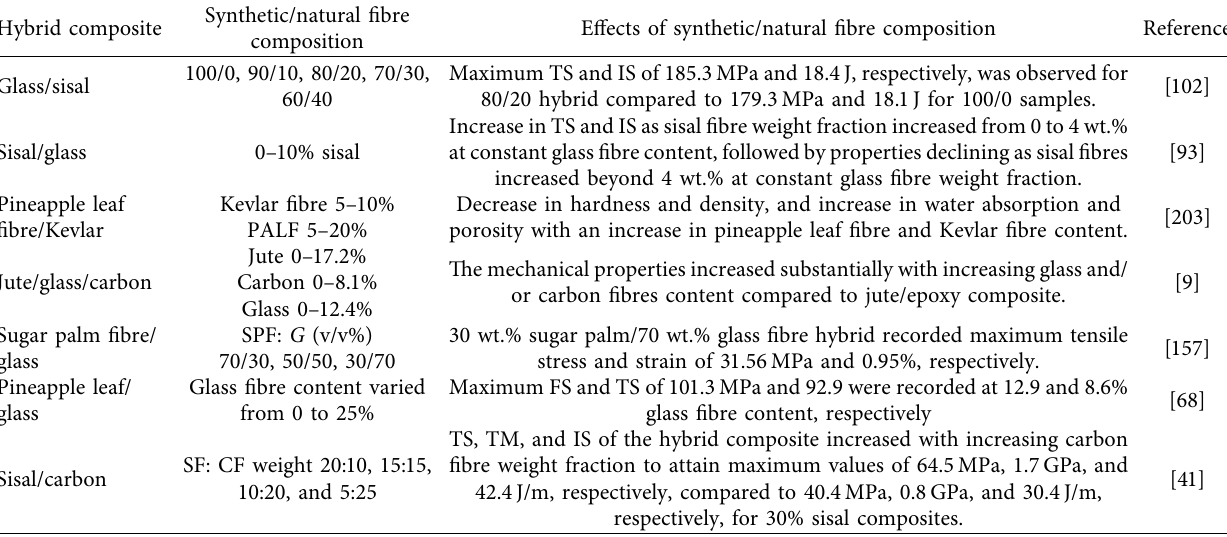
Table 8: Effect of synthetic/natural fibre composition on physical and mechanical properties of resultant hybrid composites. Synthetic/natural fibre Hybrid composite Effects of synthetic/natural fibre composition